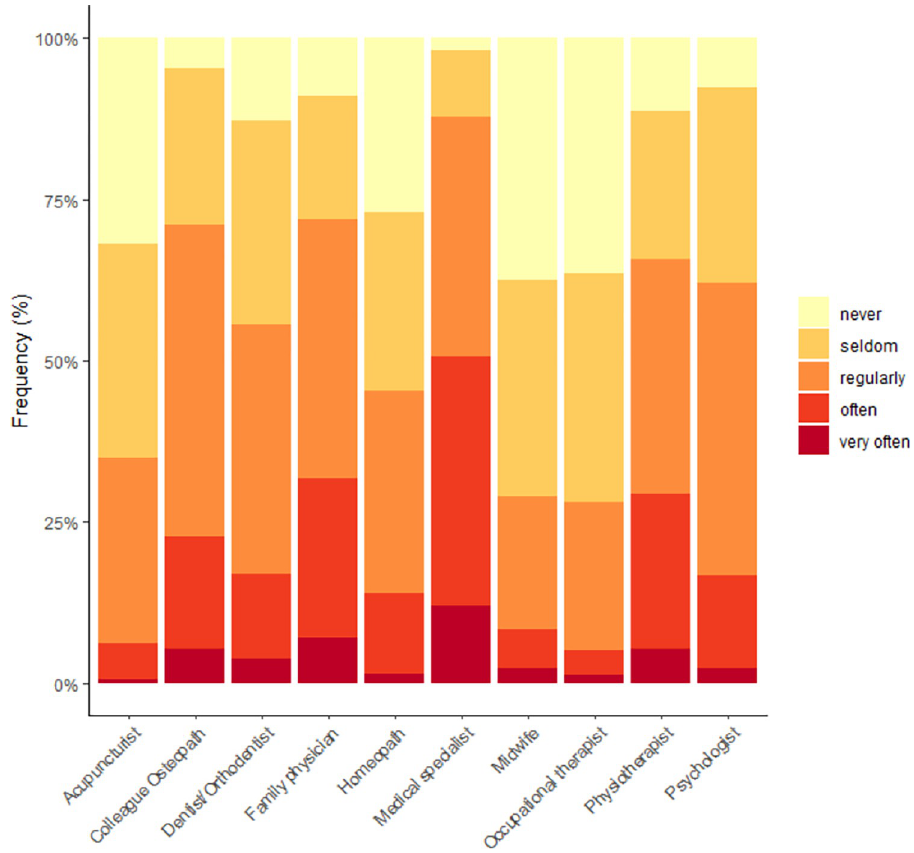
Fig 2. Frequency of referring patients by osteopathic practitioners to other healthcare professionals